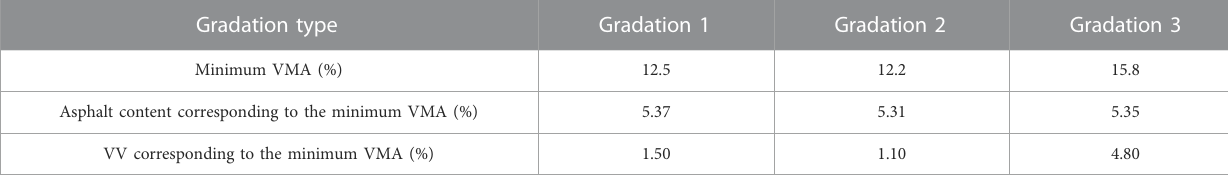
TABLE 17 Calculated